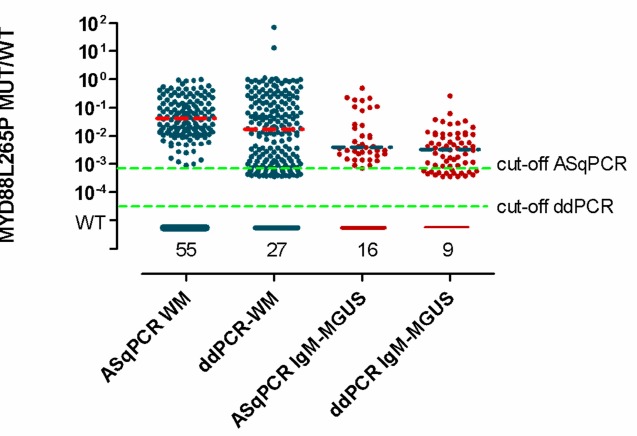
Figure 3. Mutational load comparison between WM and IgM-MGUS. The dashed orange and blue lines show, respectively, the median of MYD88 L265P mutational values in WM and IgM-MGUS patients. WT: Wildtype (quantitative value outside the limit of blank. Limit of blank was calculated based on healthy subjects as the mean value +1 SD); 10 − 4 : 1 × 10 − 4 .